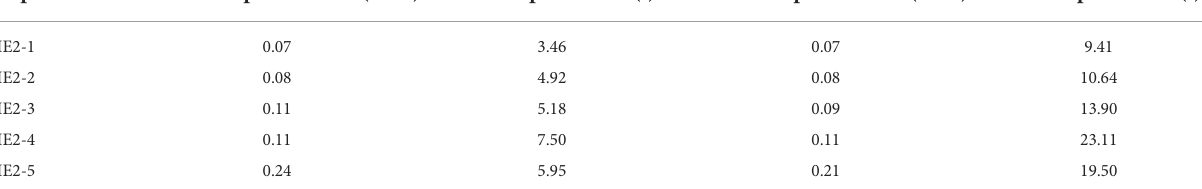
TABLE 5 MAEs of reconstructed tidal currents using part of the observations and prescribed tidal currents in each IE at the mooring MP3.